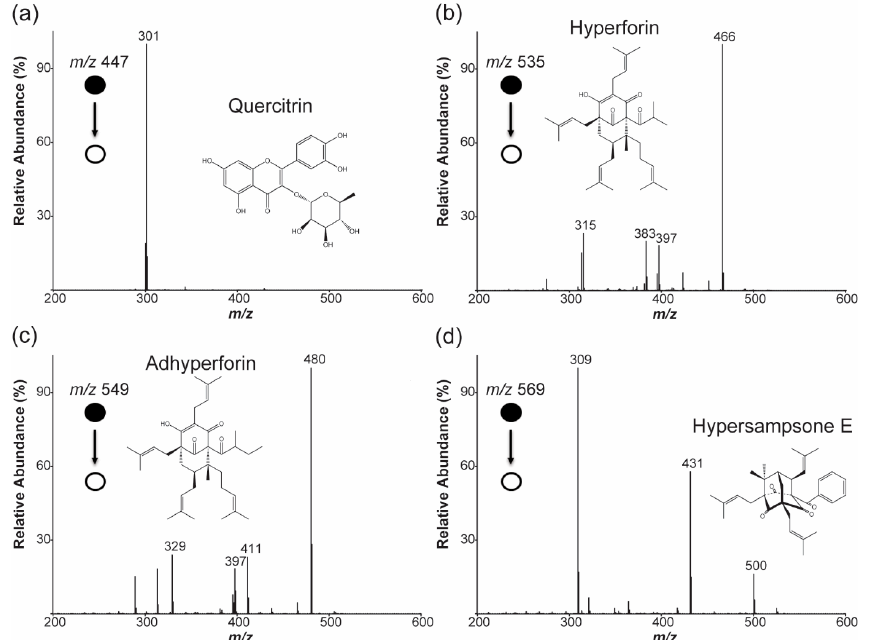
Figure 3. First-generation product ion spectra (MS/MS) for the ions detected in the spectrum in Figure 2 at ( a ) m / z 447, ( b ) m / z 535, ( c ) m / z 549, and ( d ) m / z 569. The tentatively identified molecule and